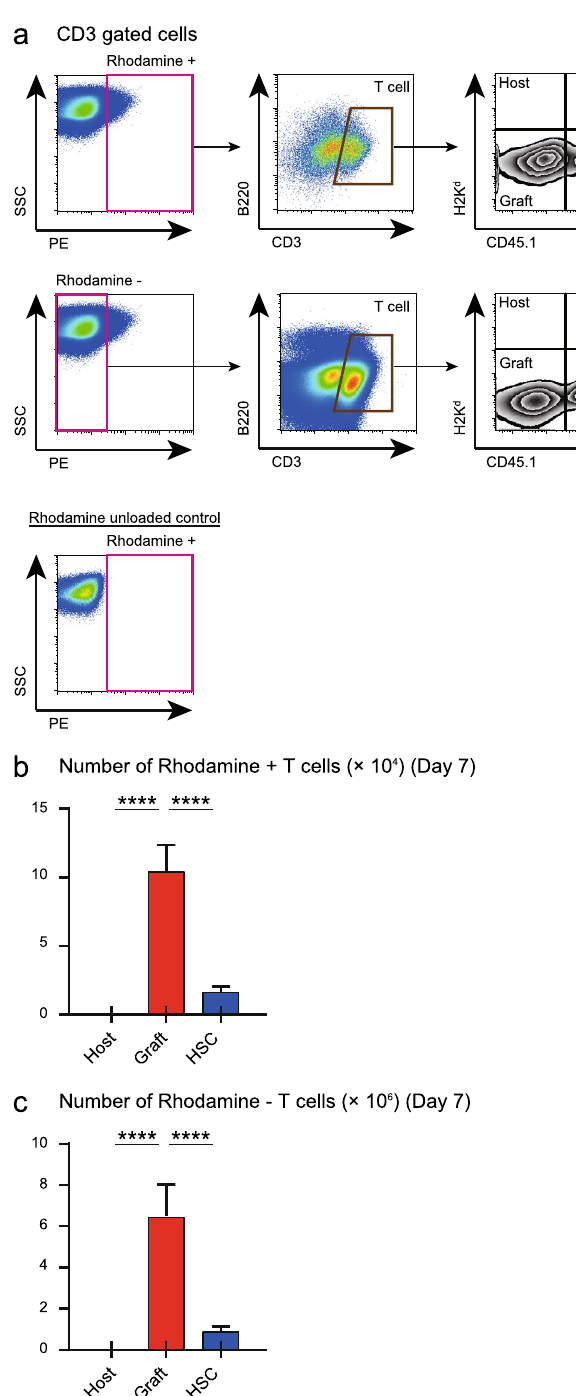
Figure 5. Splenic T cells uptake lipo α-GC after BMT. Splenic T cells were analyzed on day 7 after murine BMT with reduced PTCy as shown in Fig. 4a. ( a ) Representative data of flow cytometric analysis regarding Rhodamine positive or negative CD3 + T cells are shown. Their chimeras are evaluated as host (H2Kd + CD45.1-) derived or donor graft (H2Kd-CD45.1-) derived or donor stem cell (H2Kd-CD45.1 +) derived, respectively. ( b ) APCs taking in lipo α-GC and their chimeras on day7 after BMT are revealed, by flow cytometric analysis (n = 6). ( c ) APCs not taking in lipo α-GC and their chimeras on day7 after BMT are revealed, by flow cytometric analysis (n =